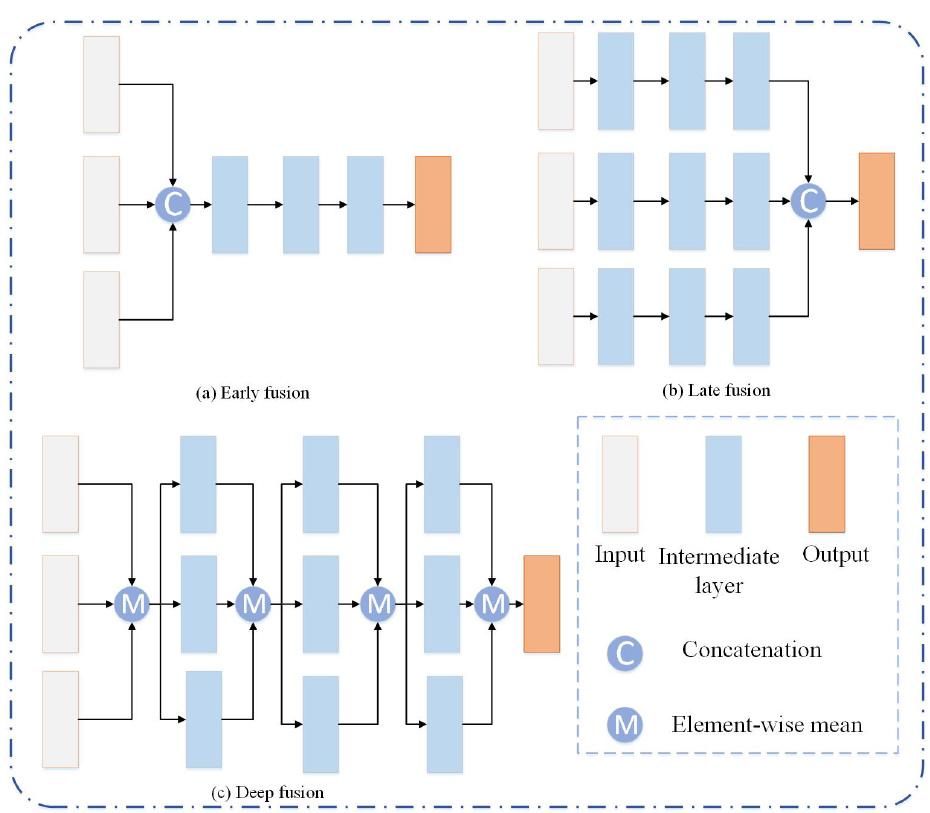
Figure 14. Architecture of different fusion